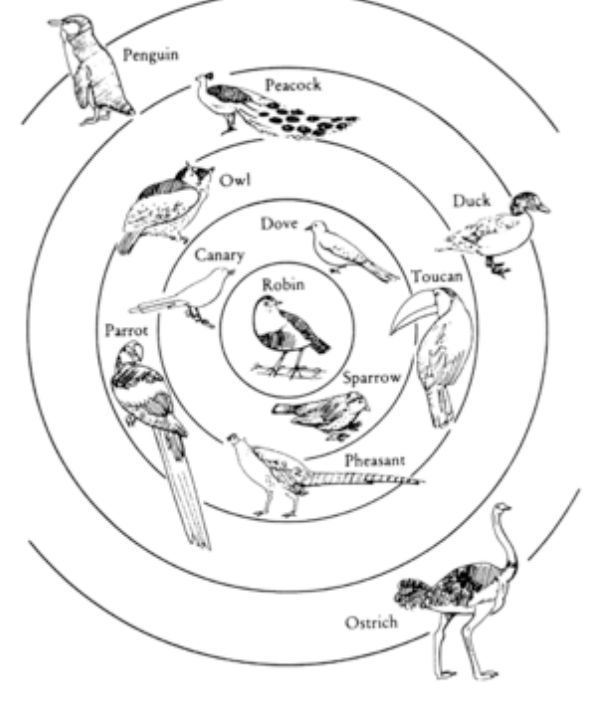
Fig. 3: Bird as a Category for North American Speakers of